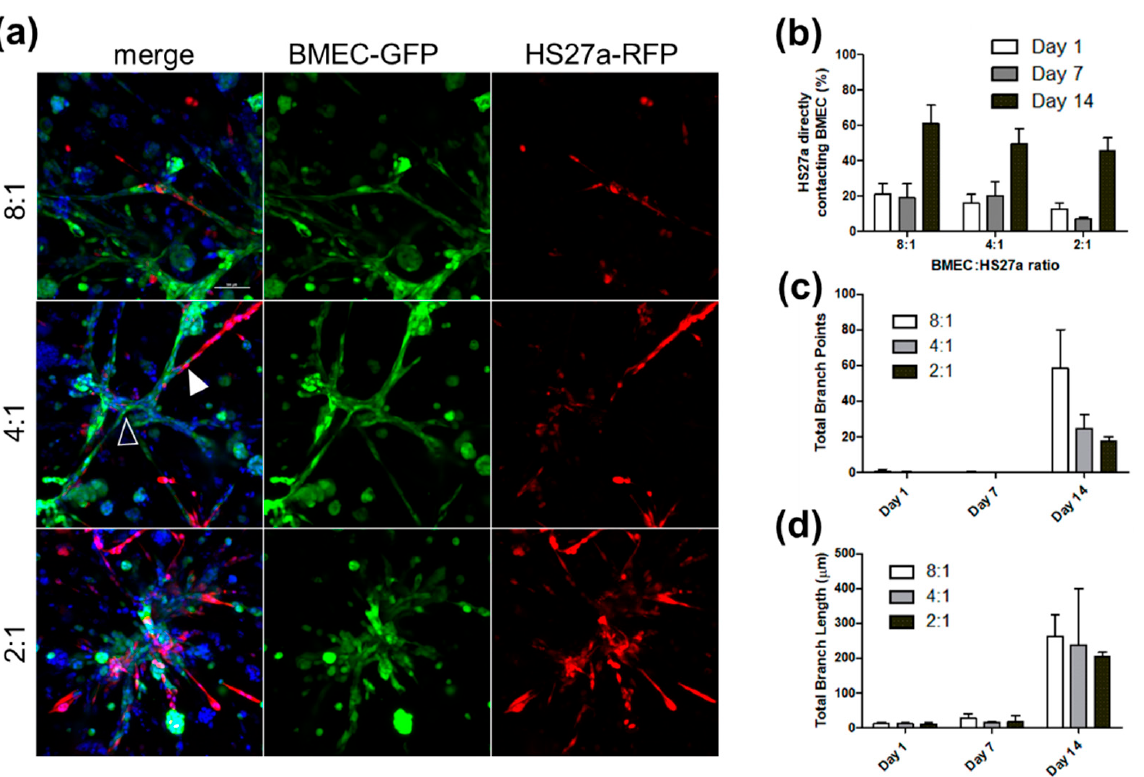
Figure 1. BMEC-to-HS27a ratio impacts endothelial network architecture. BMEC-GFP and HS27a- RFP were encapsulated in 8:1, 4:1, and 2:1 ratios, cultured for 14 days, and then labeled with Hoechst and imaged. The results show that 8:1 cultures form more intricately branched networks than 4:1 cultures, while 2:1 cultures show much less interconnectivity. HS27a-RFP is associated with BMEC- GFP structures in all conditions ( a ). The white arrow indicates the pericyte-like association of HS27a with BMEC. The white outlined arrow indicates a branch point. Scale = 100 µm. The number of HS27a directly in contact with BMEC structures increases over time in all BMEC:HS27a ratios ( b ). The total branch length is similar between BMEC:HS27a ratios ( d ), while 8:1 cultures show the largest number of branch points ( c ), indicating a more intricately branched network. Each bar represents nine images across three separate hydrogels. Error bars represent standard deviation.